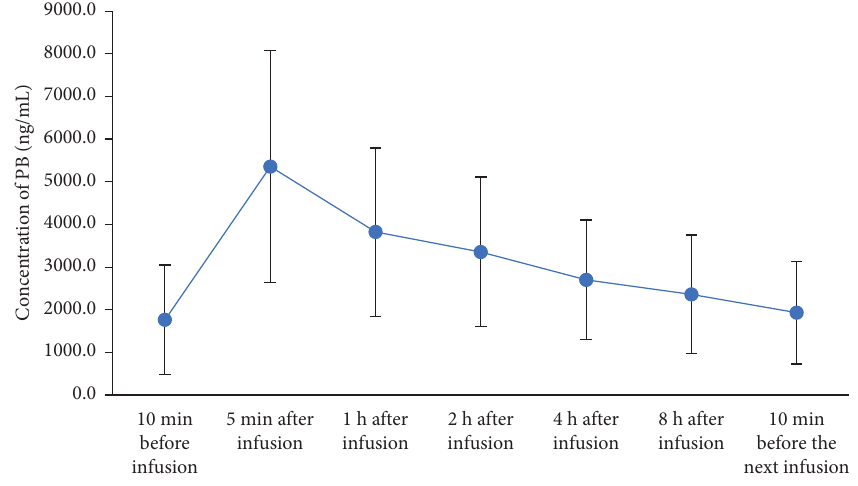
Figure 4: Polymyxin B metabolic